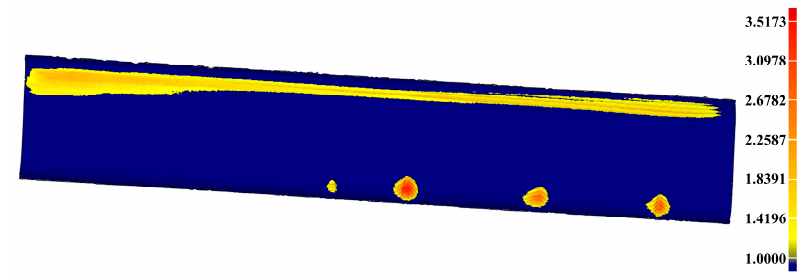
Figure 19. The practical damaged rail and final result in the second experiment. ( a ) The practical damaged-rail; ( b ) The final complete closed mesh model of the practical damaged rail; ( c ) The local magnified model of b.